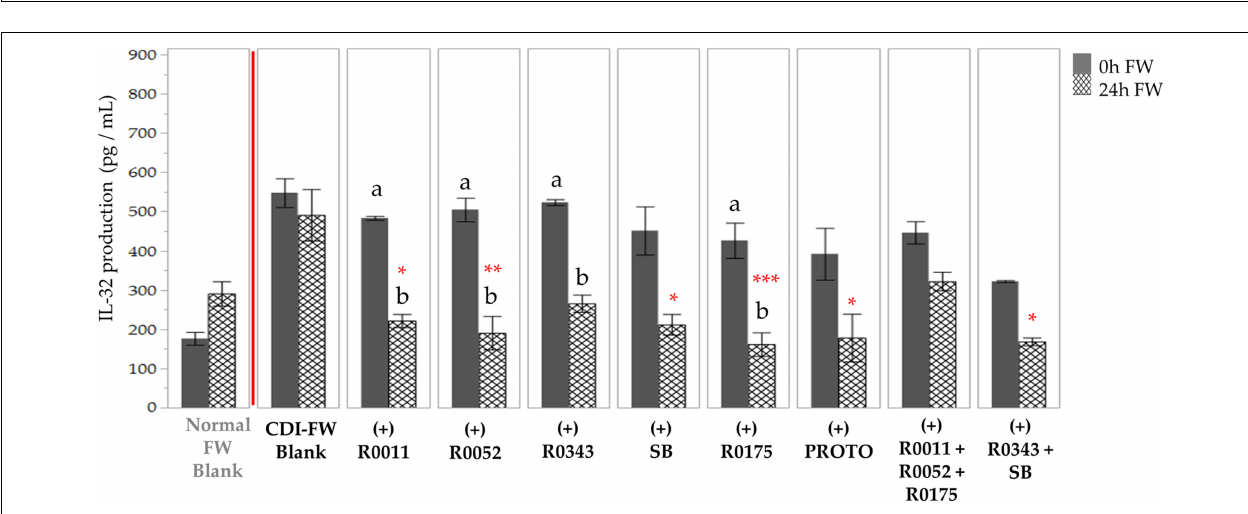
FIGURE 7 | Detection of interleukin-32 production following the exposure of T84 cells with Clostridioides difficile -infected (CDI) fecal water (FW) treatments as measured by multiplex assay. , cells treated with FW collected at T = 0 h; , cells treated with FW collected at T = 24 h. Values are shown as mean ± SEM. Means at time points within treatments without a common letter are significantly different from each other ( p < 0.05). The symbol * represents significant differences (* p < 0.05; ** p < 0.01; *** p < 0.001) between treatment and CDI-FW blank at T = 24 h. R0011 = L. rhamnosus R0011; R0052 = L. helveticus R0052; R0343 = L. rhamnosus GG R0343; SB = S. boulardii CNCM I-1079; R0175 = B. longum R0175; PROTO = ProtecFlorTM; R0011 + R0052 + R0175 = combination of L. rhamnosus R0011, L. helveticus R0052 and B. longum R0175; R0343 + SB = combination of L. rhamnosus GG R0343 and S. boulardii CNCM